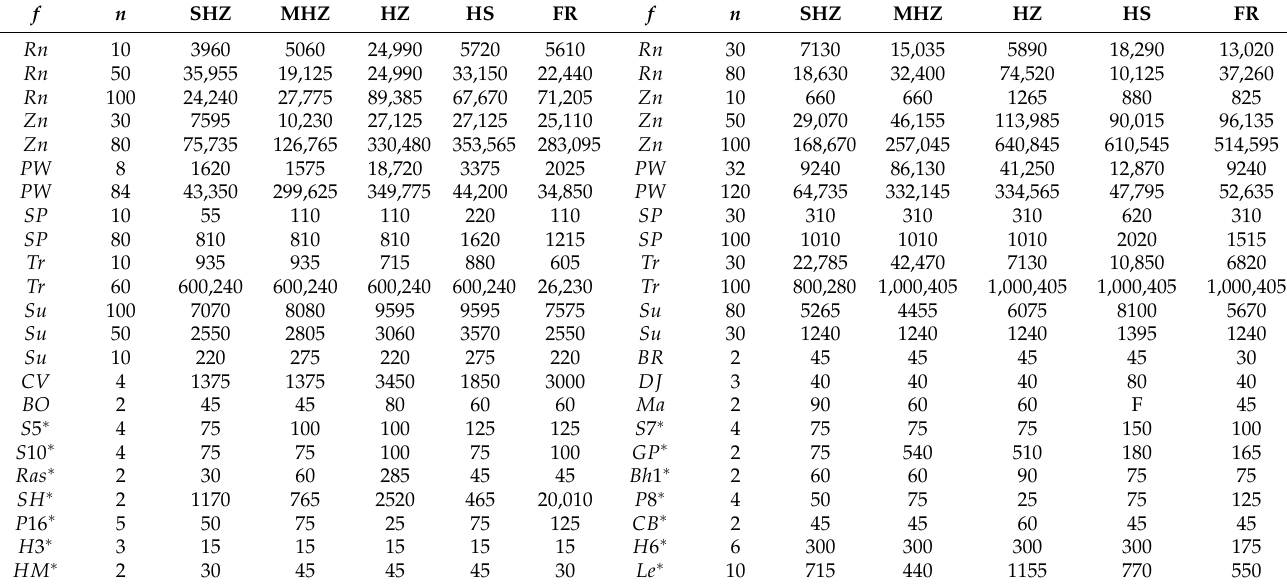
Table 5. The number of best function